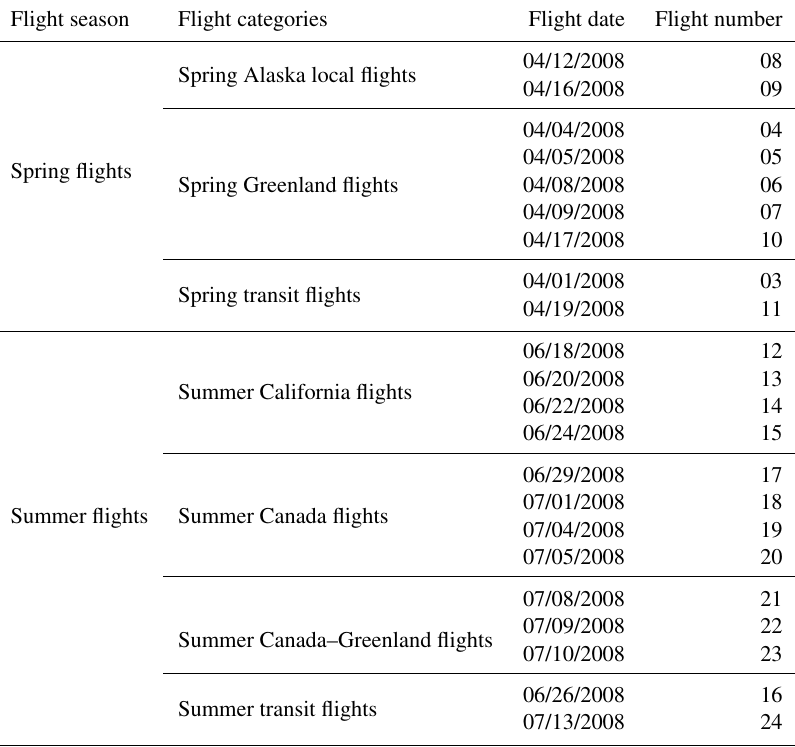
Table 1. NASA ARCTAS flight categories for spring and summer 2008. Dates are indicated in mm/dd/yyyy format.